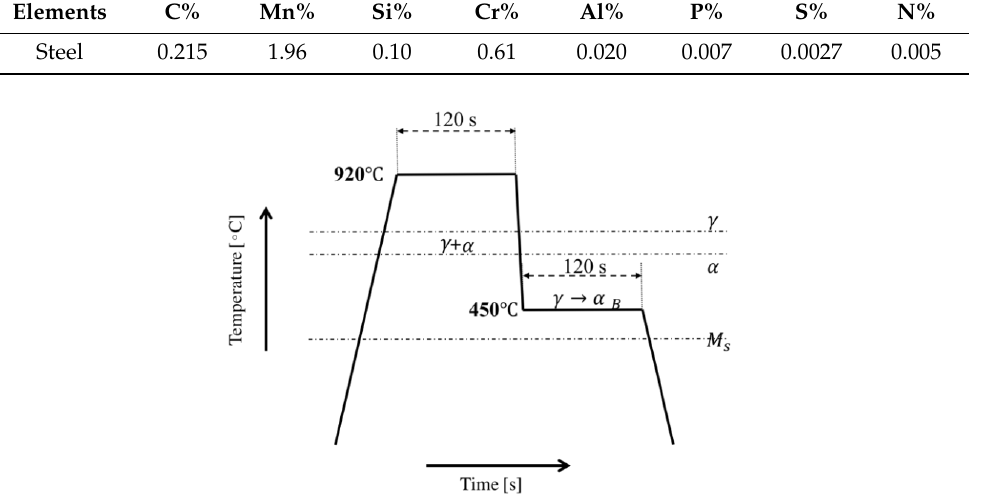
Figure 1. Schematic illustration of the annealing cycle used to develop the bainitic steel.